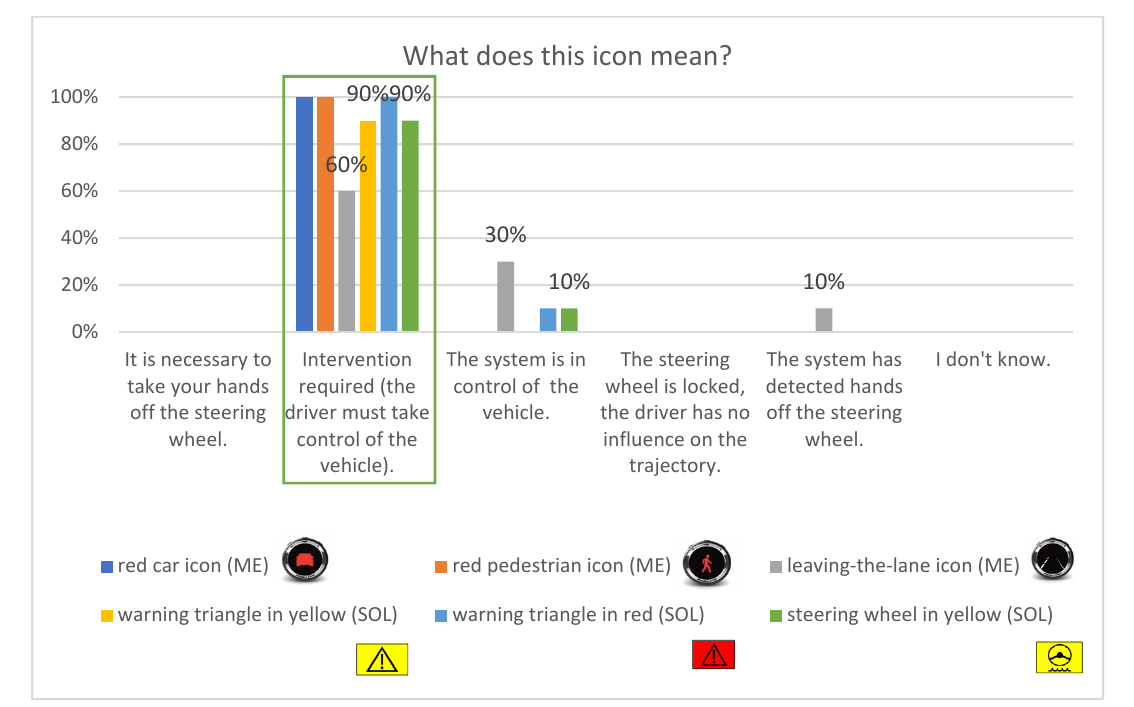
Figure 5. Comprehension Test, assessing the comprehension of the message conveyed by the icons (“What does this icon mean?”).